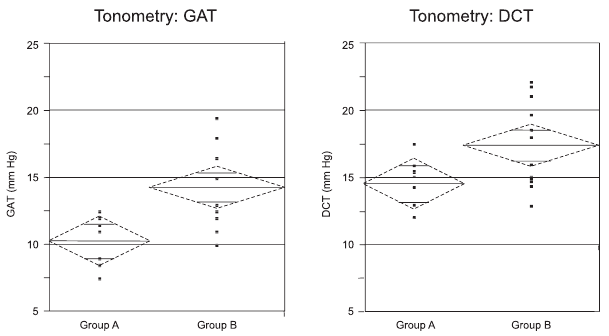
Figure 1 - The range of mean intraocular pressure (IOP) readings by Goldman applanation tonometry (GAT) and by dynamic contour tonometry (DCT) for groups A and B